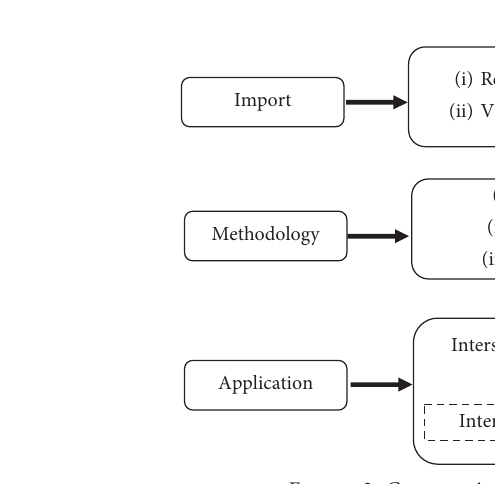
Figure 1: Schematic of intersection evaluation.